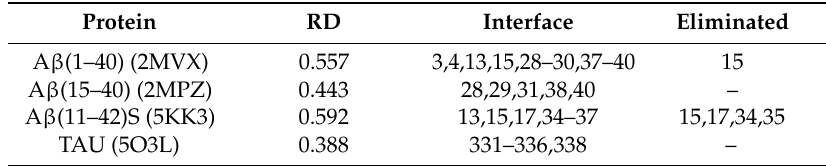
Table 2. RD values for interfaces in superfibrils. Residues present in the interface are given. The term A β (11–42)S means A β (11–42) amyloid in the form of a superfibril.